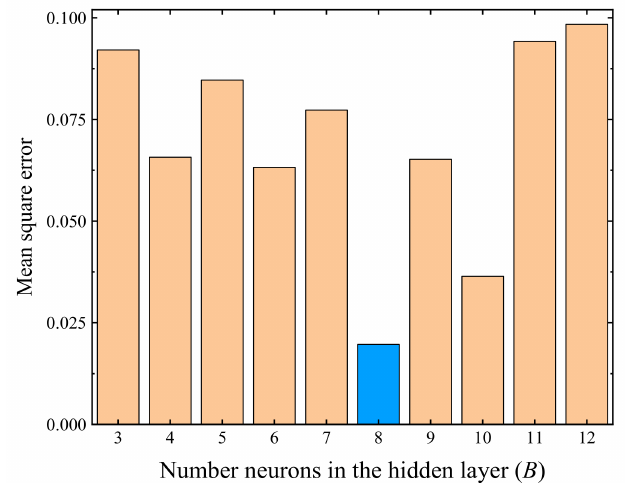
Figure 12. Mean square error with different B values (regarding the ε s